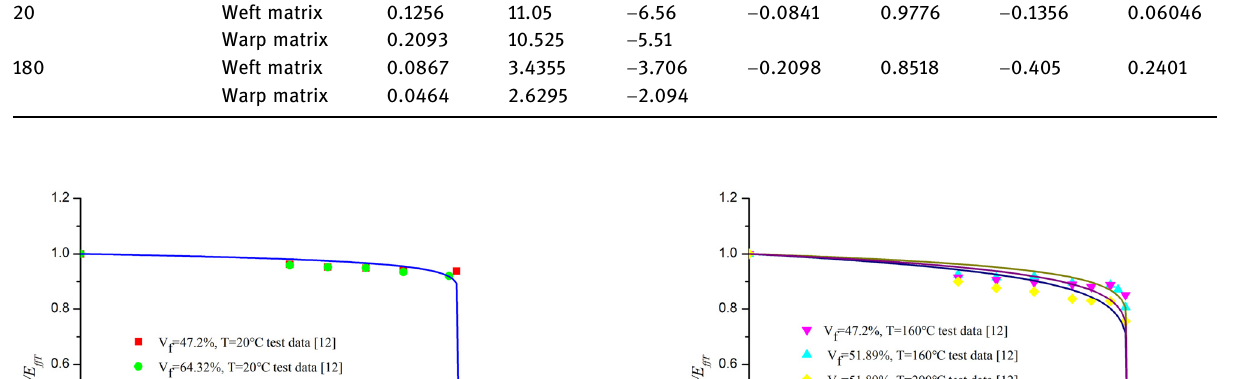
Table 5: Unknown parameters of the yarn matrix damage evolution equation Temperature ( °C